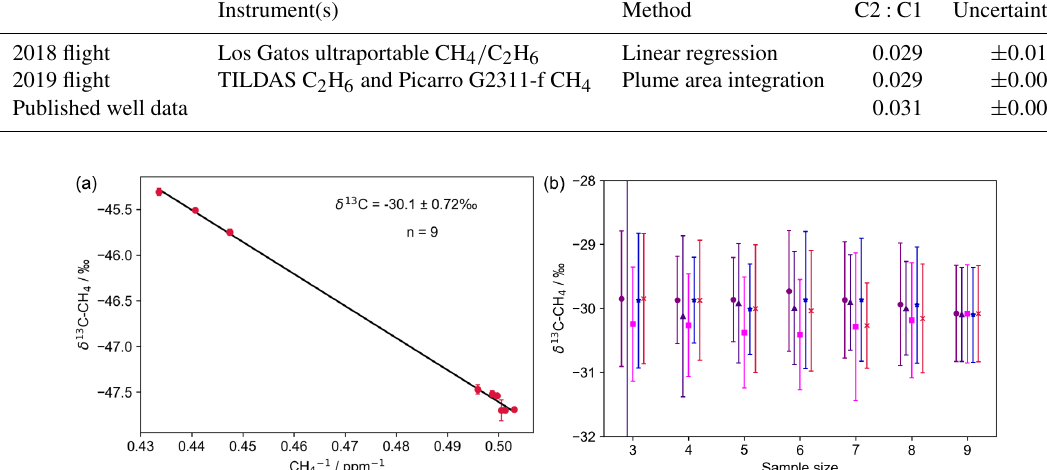
Figure 8. (a) Keeling plot determined using nine samples collected around one installation, assumed to be the single source of excess CH 4 . (b) An illustration of the variation in δ 13 C CH4 source signature and its uncertainty determined by Keeling plot analyses for reduced sample sizes. Each analysis represents a single Monte Carlo experiment with the original data, reducing the number of data points to the sample size indicated at random; the δ 13 C CH4 source signature is then calculated with the remaining sample points. Error bars are 2 times the standard